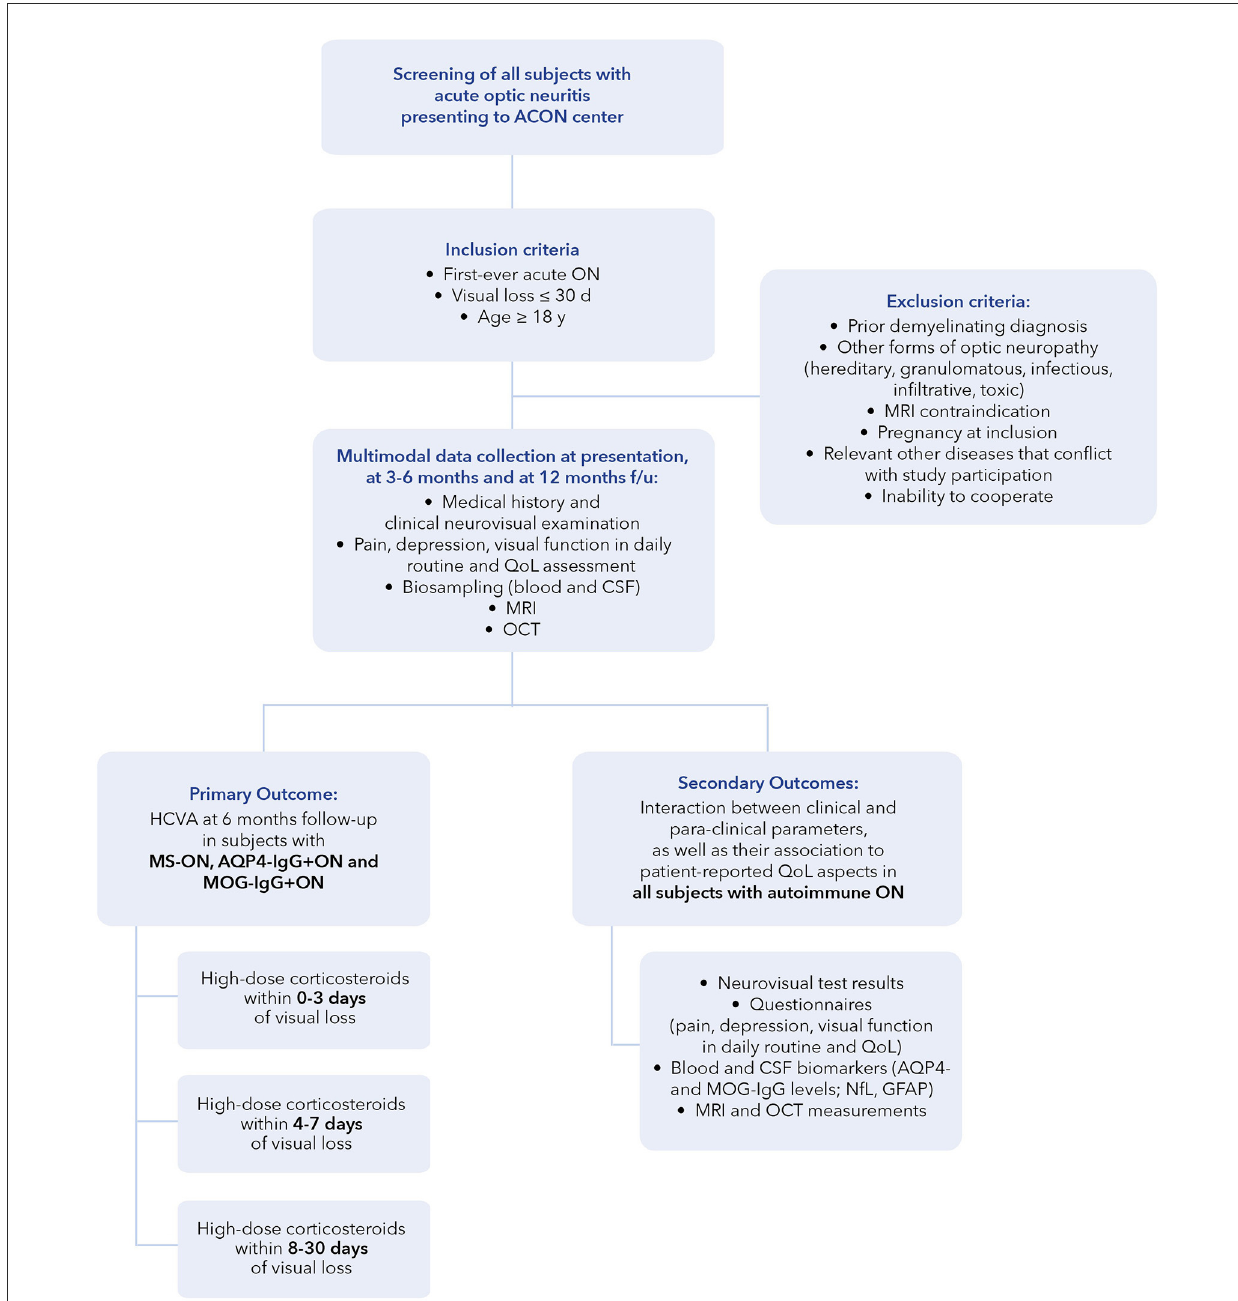
FIGURE2 Flowchart of ACON study design. ACON, Acute Optic Neuritis Network; AQP4, aquaporin-4; CSF, cerebrospinal fluid; days; f/u, follow-up; GFAP, glial fibrillary acidic protein; MRI, magnet resonance imaging; MOG, myelin-oligodendrocyte glycoprotein; NEI-VFQ-25, National Eye Institute Visual Function Questionnaire; NfL, neurofilament light chain; OCT, optical coherence tomography; ON, optic neuritis; QoL, quality of life; y,